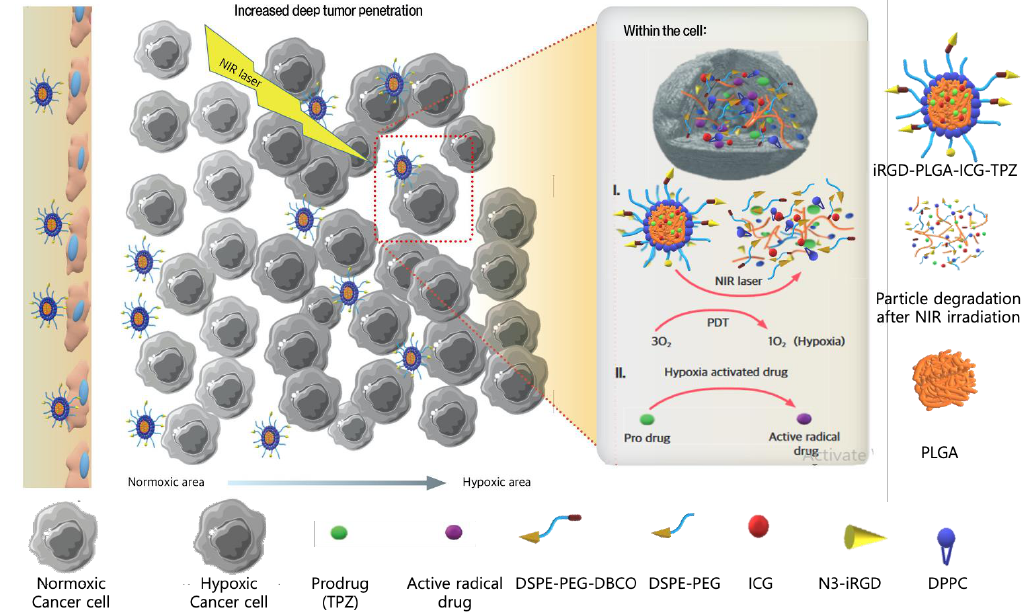
Figure 7. Schematic illustration of hypoxia activated drug delivery system (iRGD-PLGA-ICG-TPZ) via tumor targeting moiety, accompanied with photodynamic therapy (PDT). Targeted nanoparticles (NPs) penetrated to the deepest parts of the tumor, hypoxic areas. PDT of photosensitizer plus near infra-red (NIR) irradiation provided an environment less in oxygen by consuming O 2 and producing reactive oxygen species (ROS). In addition, PDT caused NP structure degradation to release hypoxia-responsive prodrug. Intensified hypoxic areas triggered the activation of prodrug into radical chemotherapeutic drugs. iRGD, penetrating cyclic peptide; TPZ, tirapazamine; PLGA, poly (lactic-co-glycolic acid); DPPC, 1,2-dipalmitoyl-sn-glycero-3-phosphocholine; PEG, polyethylene glycol; DPPC, 1,2-dipalmitoyl-sn-glycero-3-phosphocholine, DSPE, 1,2-distearoyl-sn-glycero-3-phosphoethanol-amine; DBCO, dibenzocyclooctyl; ICG, indocyanine green.